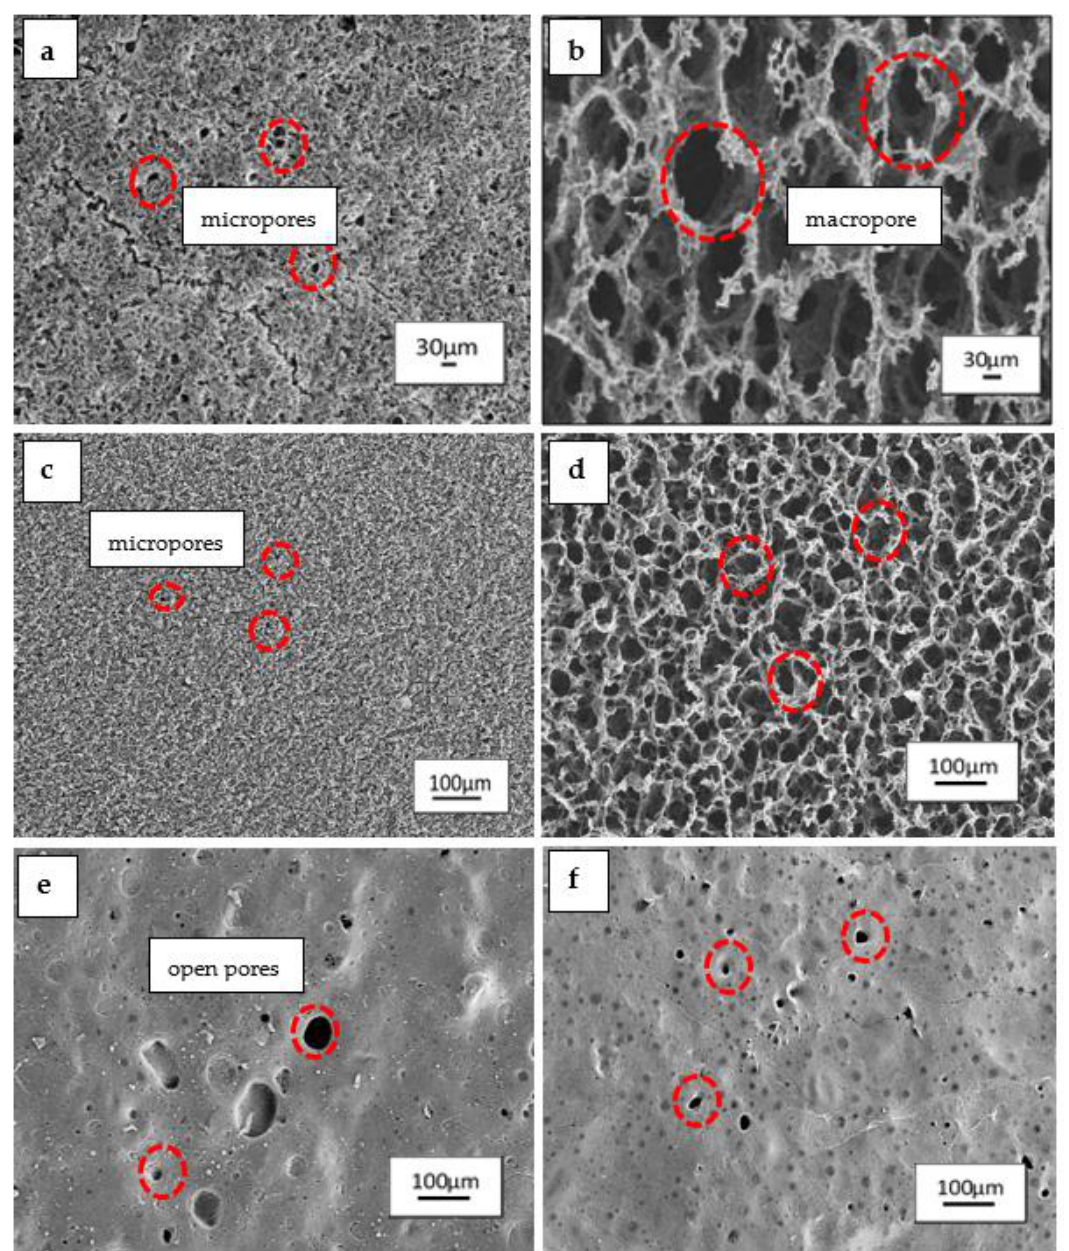
Figure 2. Surface morphology of P(3HB-co-4HB)/gelatine blend scaffolds with final weight of ( a ) 0.79g-(P27mol%G10); ( b ) 0.4g-(P27mol%G10); ( c ) 0.79g-(P50mol%G10); ( d ) 0.4g-(P50mol%G10); ( a ), 079g-(P27mol%G10), ( b ) 0.4g-(P27mol%G10); ( c ) 0.79g-(P50mol%G10); ( d ) 0.4g-(P50mol%G10); ( e ) 0.79g-(P82mol%G7.5); ( f ) 0.4g-(P82mol%G7.5). ( e ) 0.79g-(P82mol%G7.5); ( f )